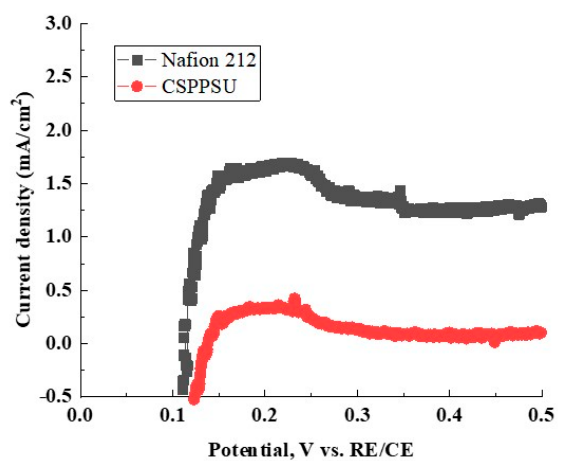
Figure 9. Hydrogen crossover properties of CSPPSU and Nafion212 membranes at 80 °C and 100% RH.